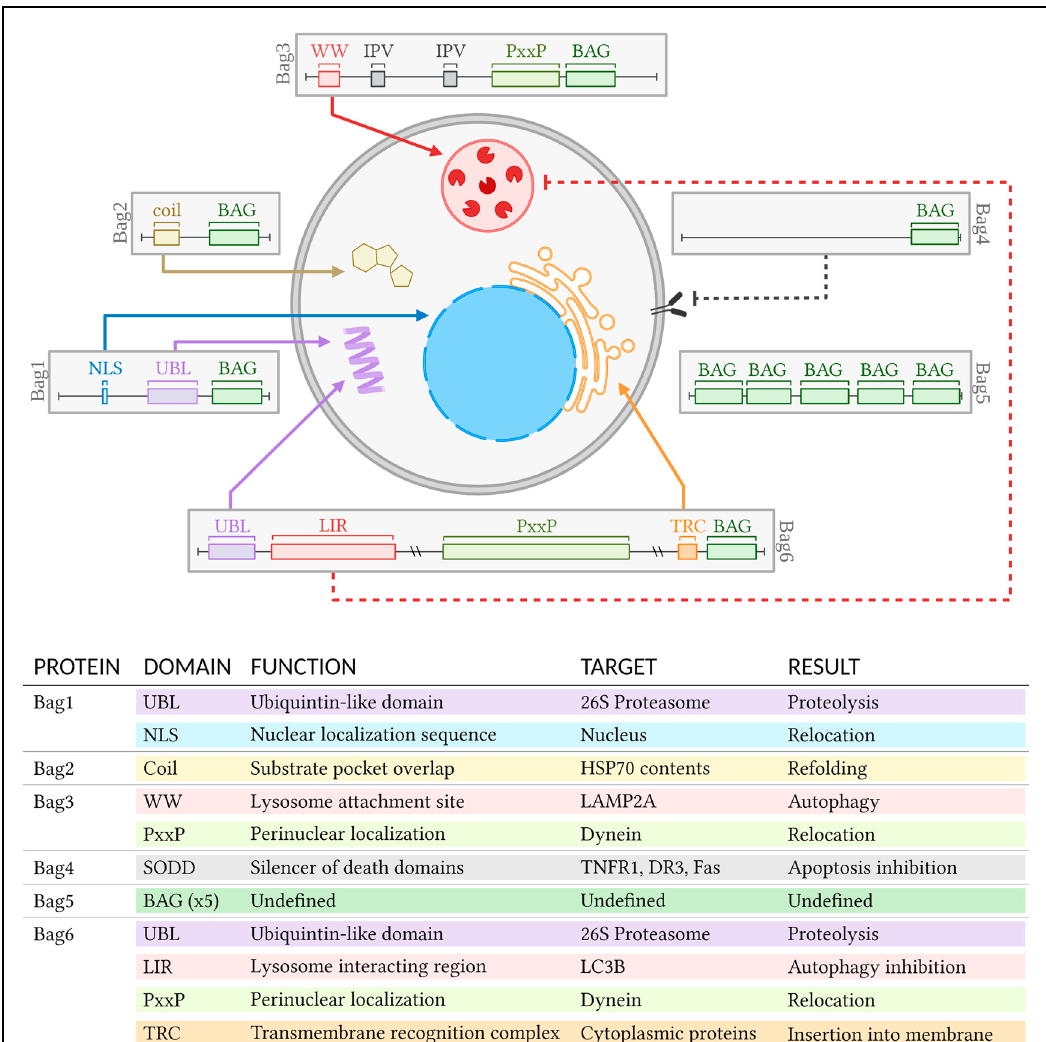
Figure 3. Roles of BCL2-associated anthogenes and their associated functional